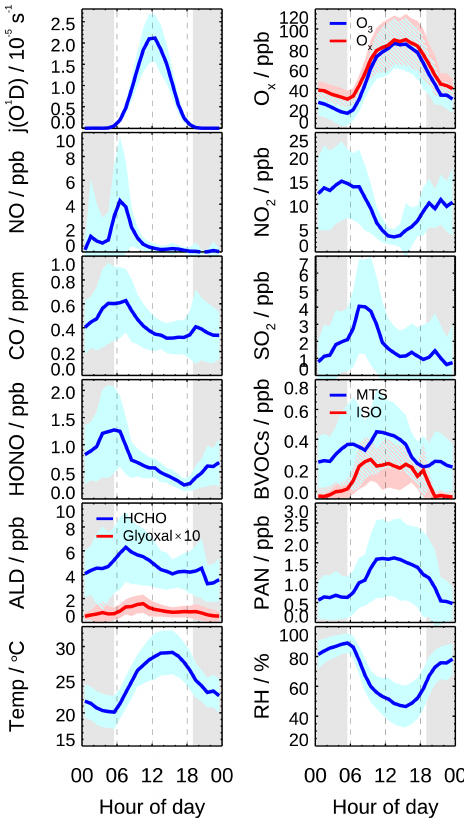
Figure 2. Mean diurnal profiles of measured photolysis frequen- cies ( j (O 1 D), relative humidity (RH), ambient temperature ( T ), and concentrations of O 3 , O x ( = O 3 + NO 2 ), NO, NO 2 , CO, SO 2 , HONO, formaldehyde (HCHO), glyoxal (CHOCHO), bio- genic VOCs (monoterpenes, isoprene), and PAN. Data are averaged over the period with HO x radical measurement. Colored areas de- note the standard deviation of variability (1 σ ). The grey areas de- note